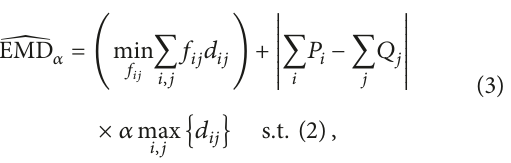
time algorithm and the time complexity is 𝑂(𝑁) [33].